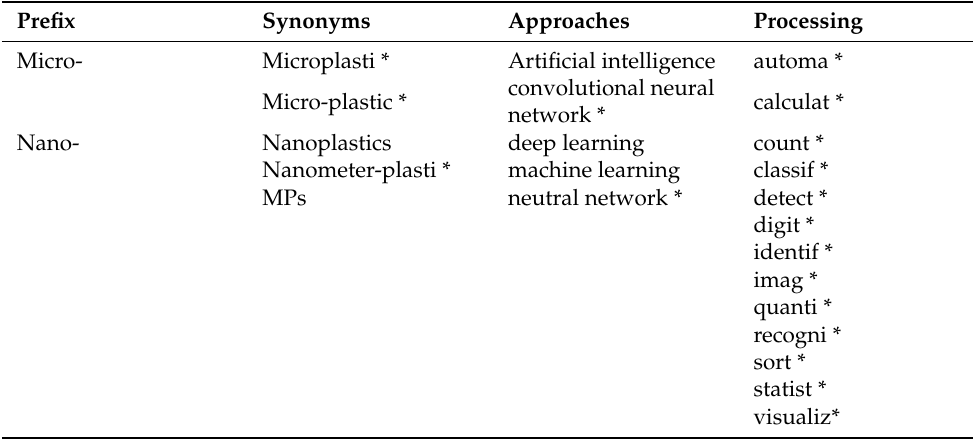
Figure 1. Whole framework of science mapping analysis. Table 1. Search